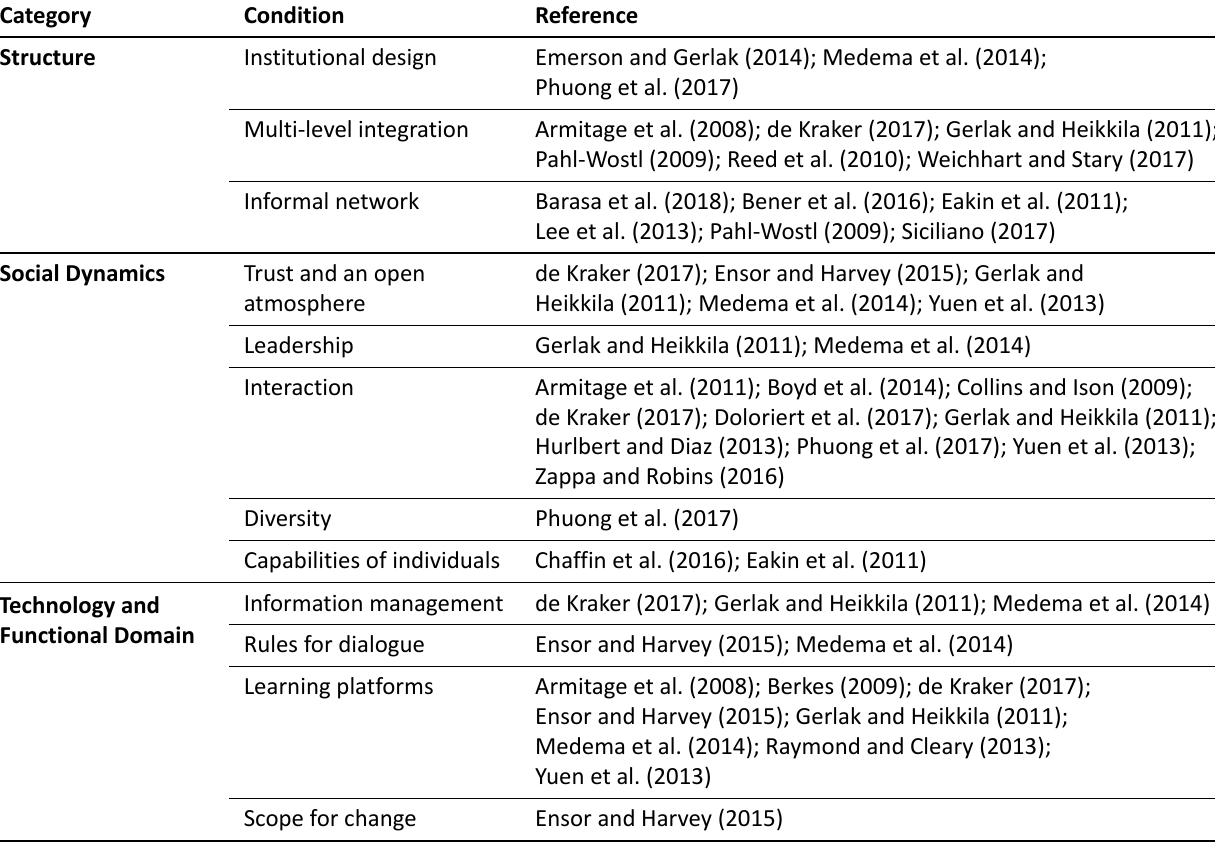
Table 2. Conditions for collective learning regarding the adaptive capacity of organisations.